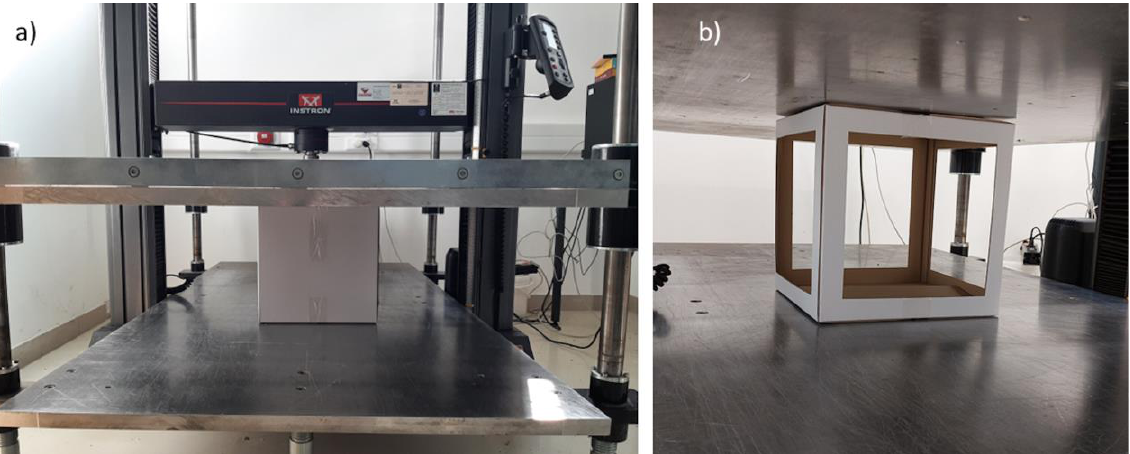
Figure 3. Box compression test (BCT): ( a ) control sample and ( b ) cutout sample (64% cutout area).